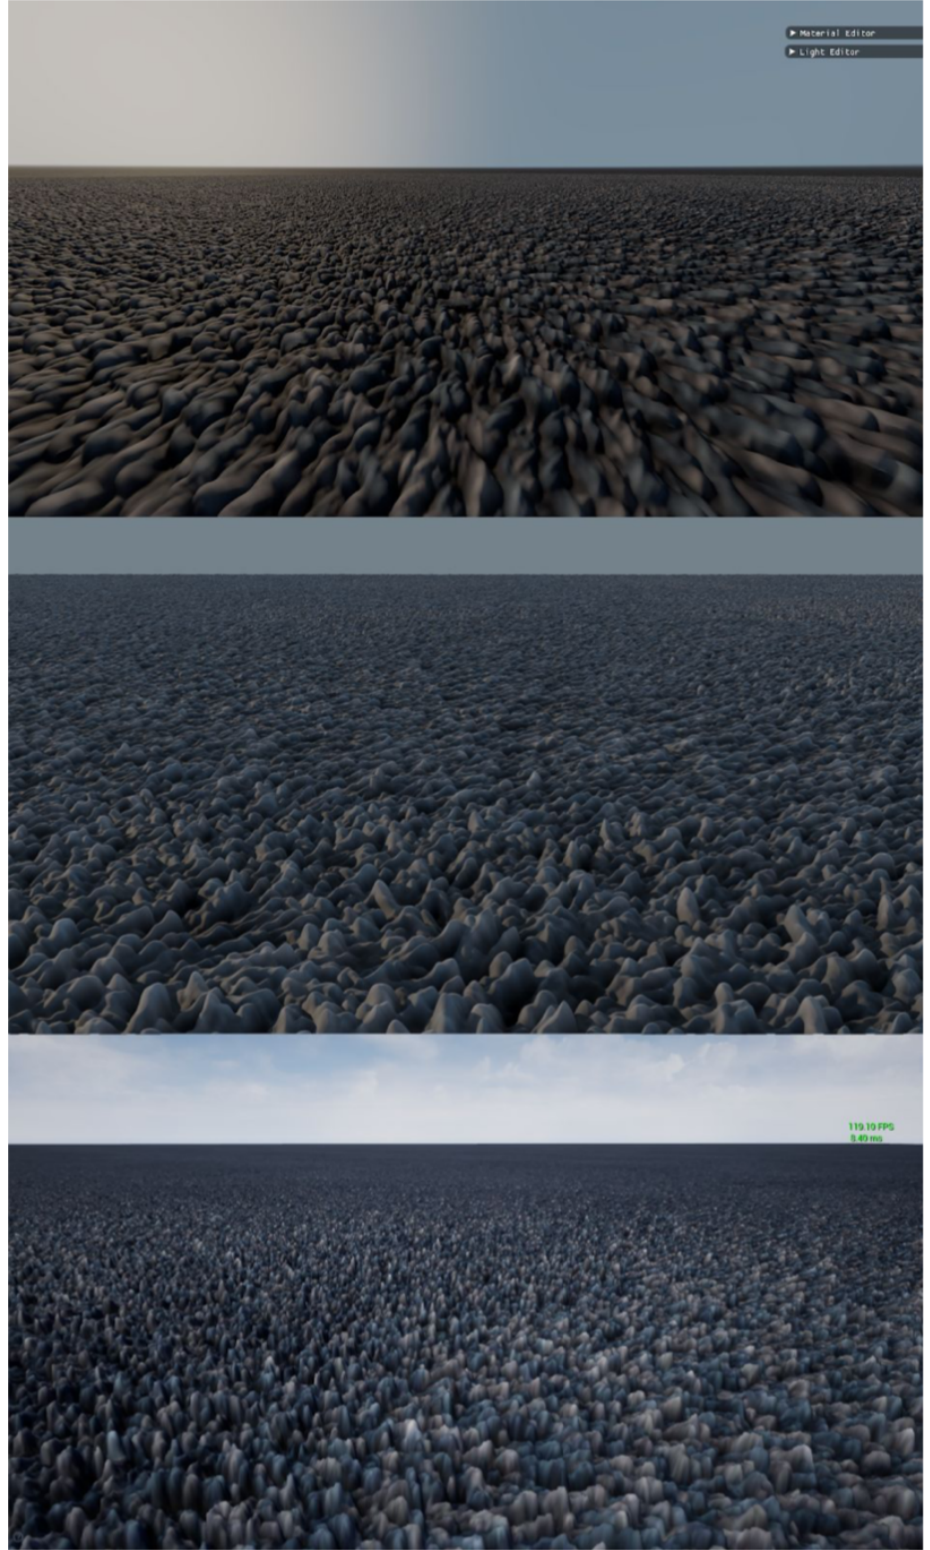
Figure 4. Raymarched displacement plane ( top ). Raytraced displacement plane rendered with Blender Cycles ( middle ). Rasterized parallax occlusion mapping plane in UE4 ( bottom